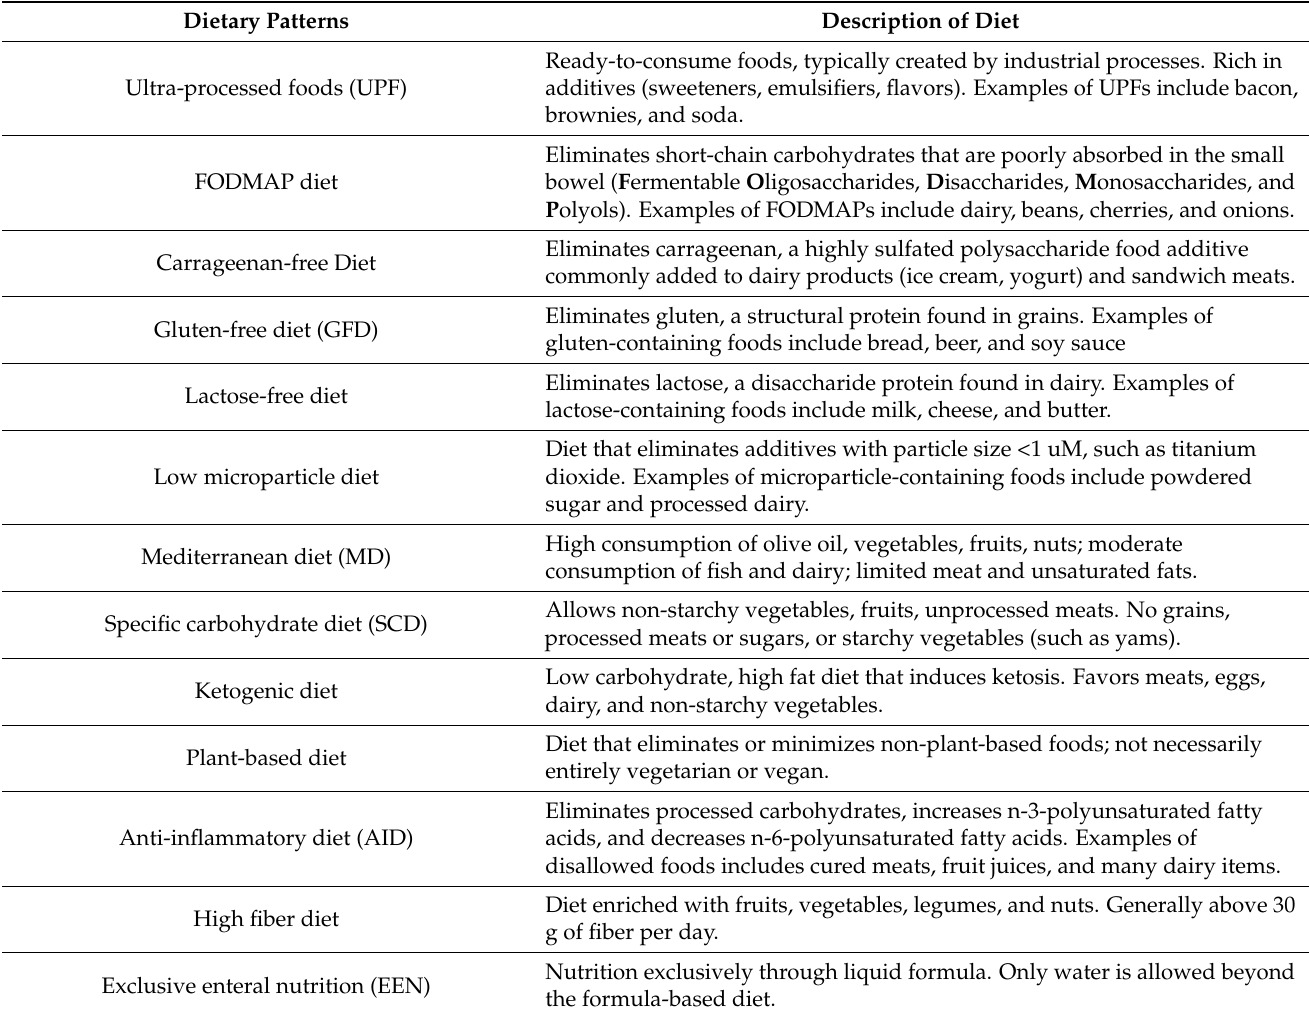
Table 1. Description of Diets Reviewed in the Article. This article reviews distinct dietary patterns which have been studied in IBD. The table provides a description of the diet and provides examples of included and excluded